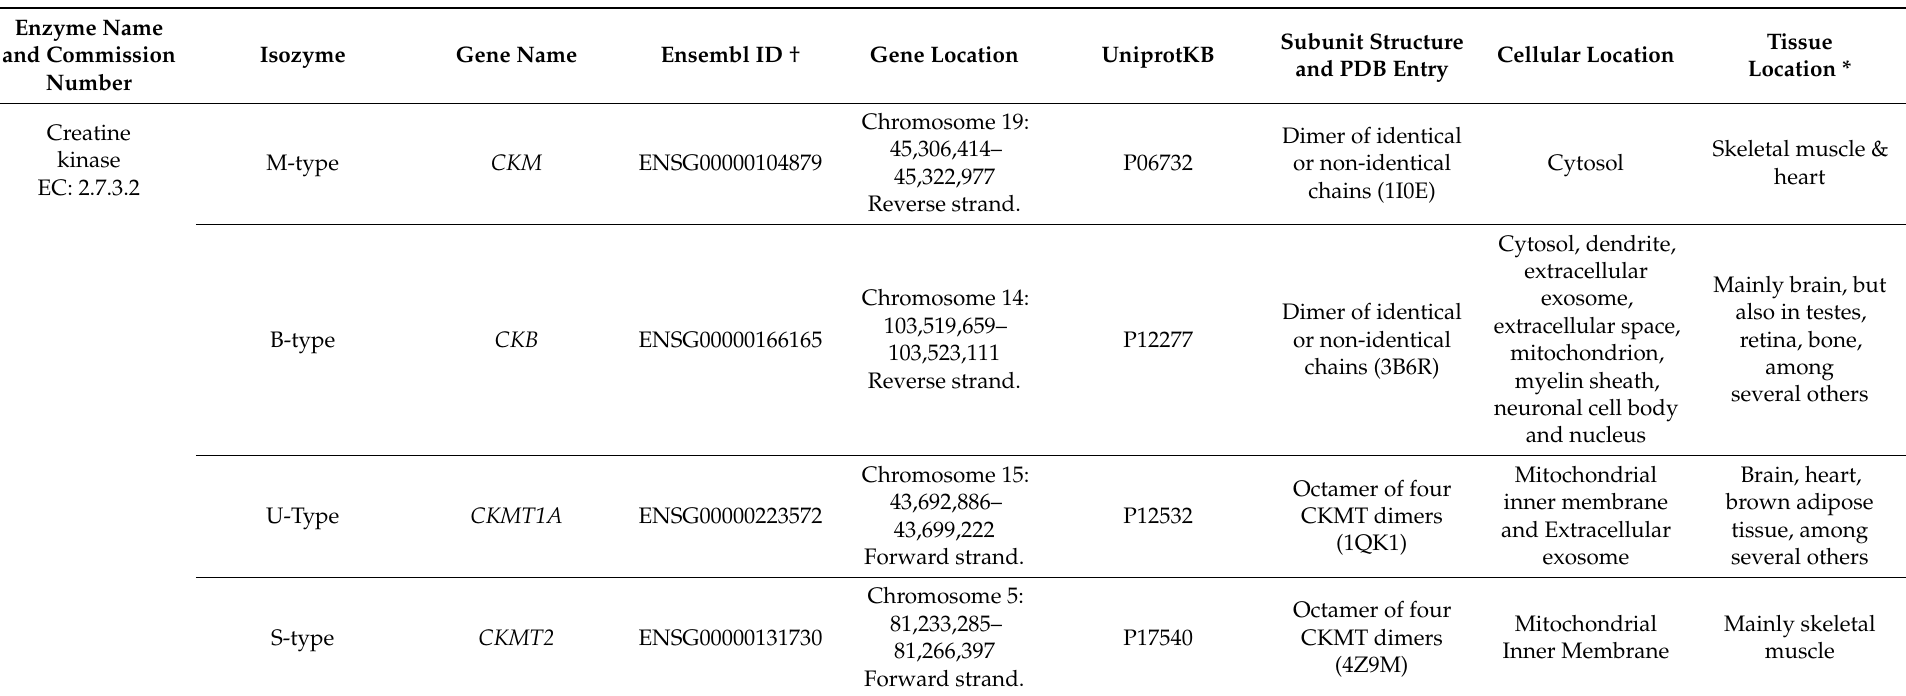
Table 1. Characteristics of the creatine kinase